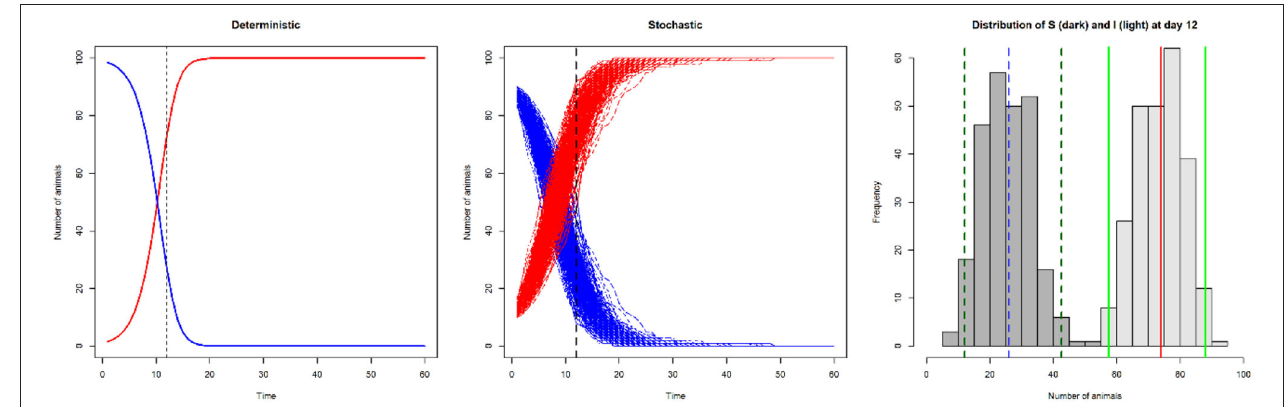
FIGURE 3 | Line plots of number of susceptible (S; blue) and infected (I; red) animals in a model with SI disease dynamics, illustrating deterministic output (left: number of infected and susceptible animals on day 12 is 73 and 27, respectively), and stochastic output (centre). The histogram illustrates the variation in the number of susceptible (dark gray; median 26 [blue dashed line], 95% CI 11–42 [dark green dashed lines]) and infected animals (light gray; median 74 [red line], 95% CI 58–89 [light green lines]) from the stochastic output at day